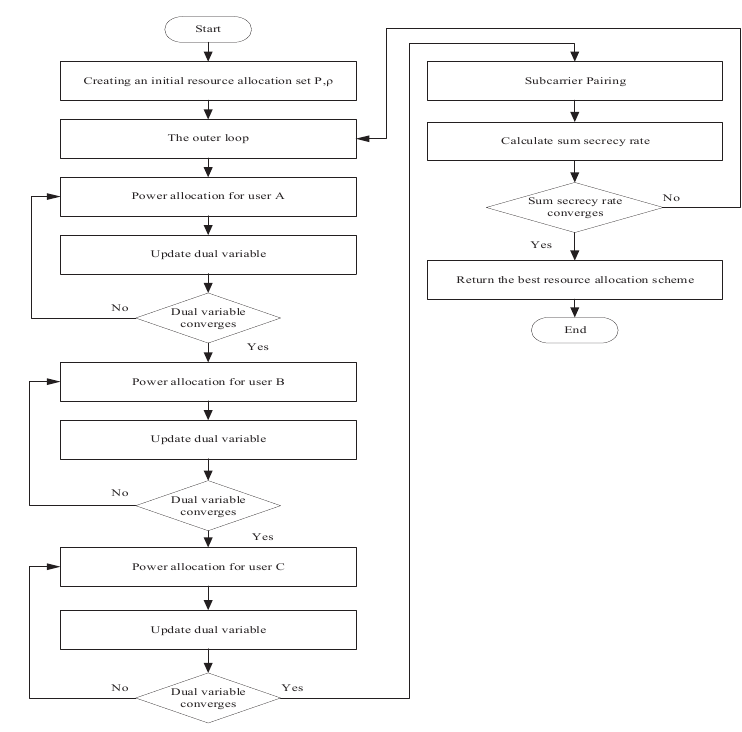
Figure 2. Flowchart of the proposed